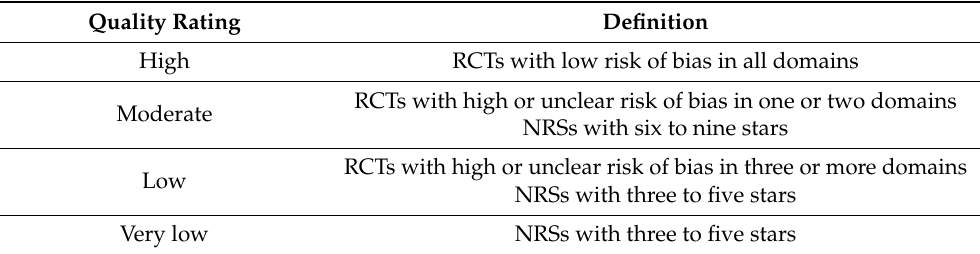
Table 2. Overall quality assessment using Cochrane’s tool for assessing risk of bias and Newcastle- Ottawa scale.